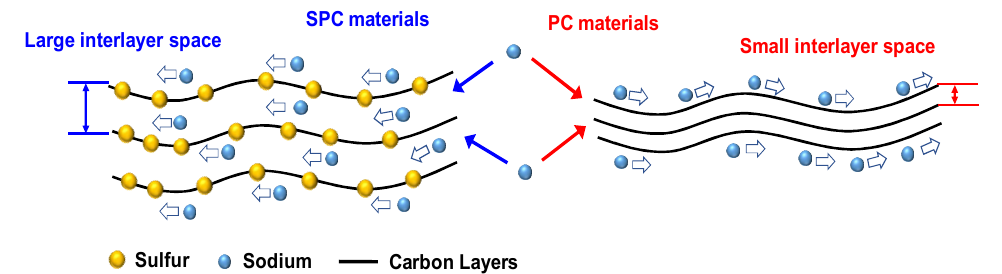
Figure 8. Images explaining the Na + storage mechanism.